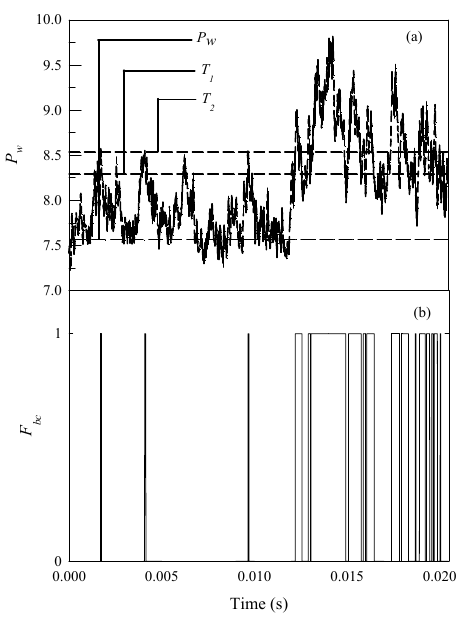
Figure 7. ( a ) Pressure signal; ( b ) boxcar using the